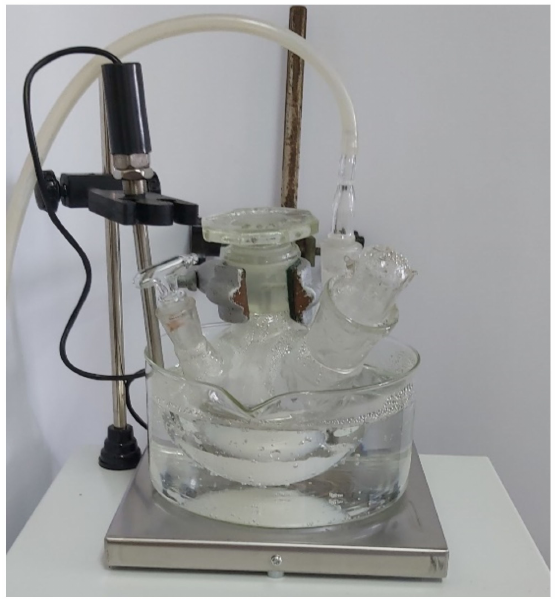
Figure 16. Apparatus for the synthesis of CMS and Ch in the addition of vanillin.